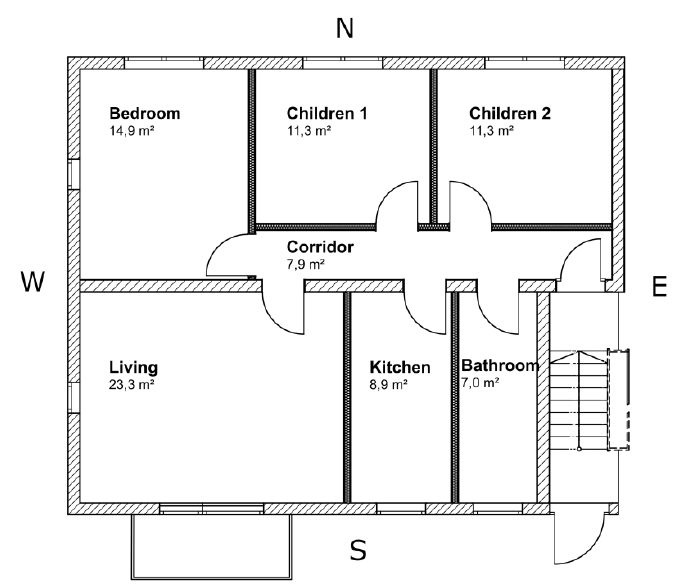
Figure 11. Building floor plan.